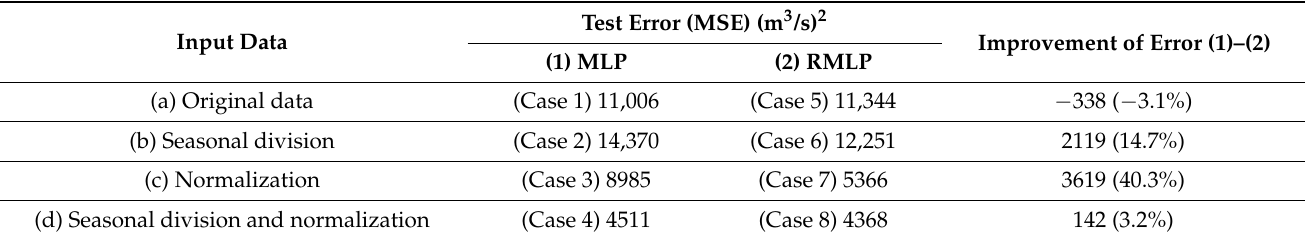
Table 8. Model test error